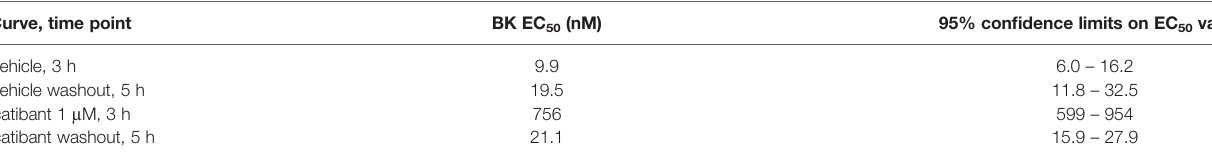
TABLE 7 | Apparent BK EC 50 values in the icatibant reversibility experiment ( Figure 6D ). Curve, time point